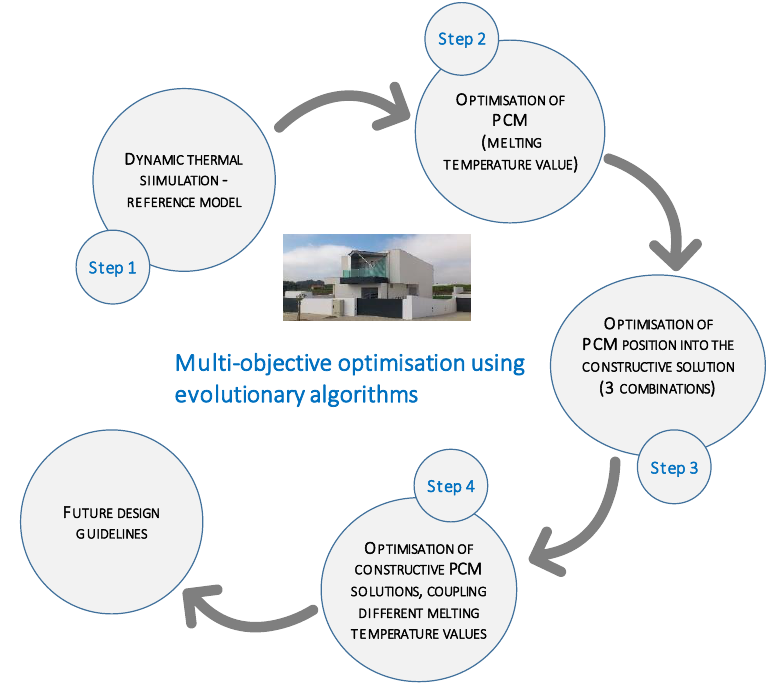
Figure 2. Methodology framework/outline.